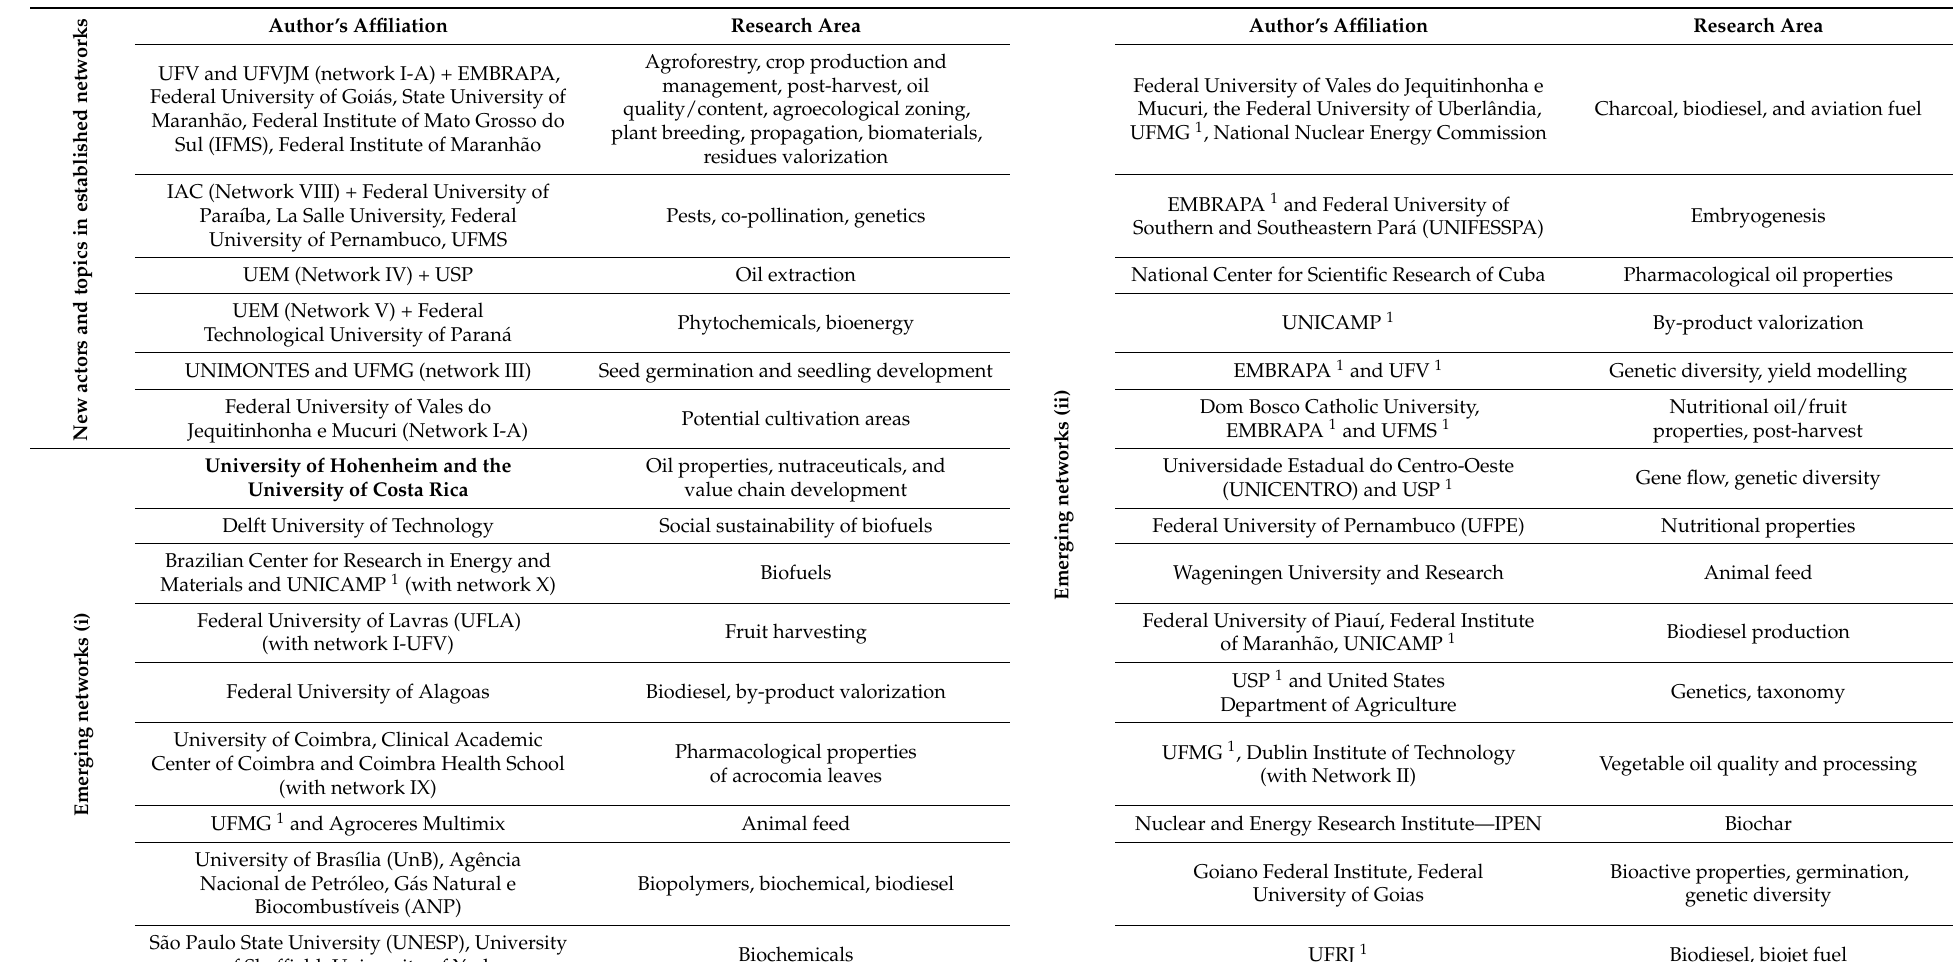
Table 1. Expansion of the acrocomia research landscape since 2019 indicating growth of established networks and emergence of new networks integrating one or multiple research